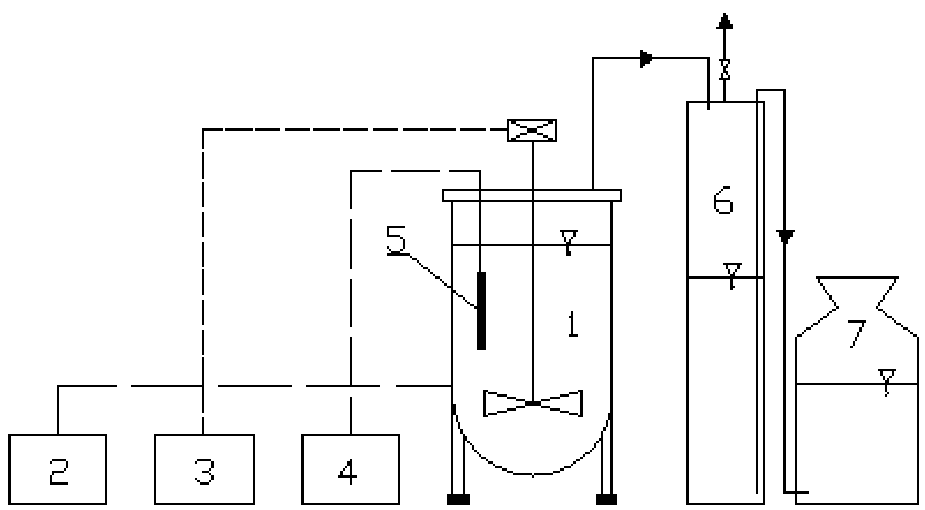
Figure 1. Diagram of the digester with instrumentation. (1) glass cylinder with an active volume of 5 dm 3 , (2) heat exchanger, (3) mixing system, (4) temperature and pH control system, (5) measuring probe, (6) biogas tank, and (7) equalization tank